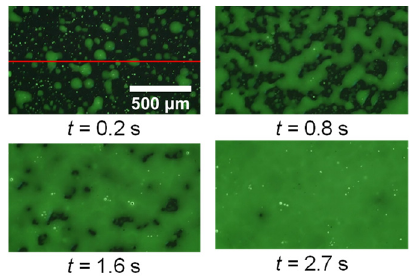
Figure 9. Fluorescence image of spray coating.